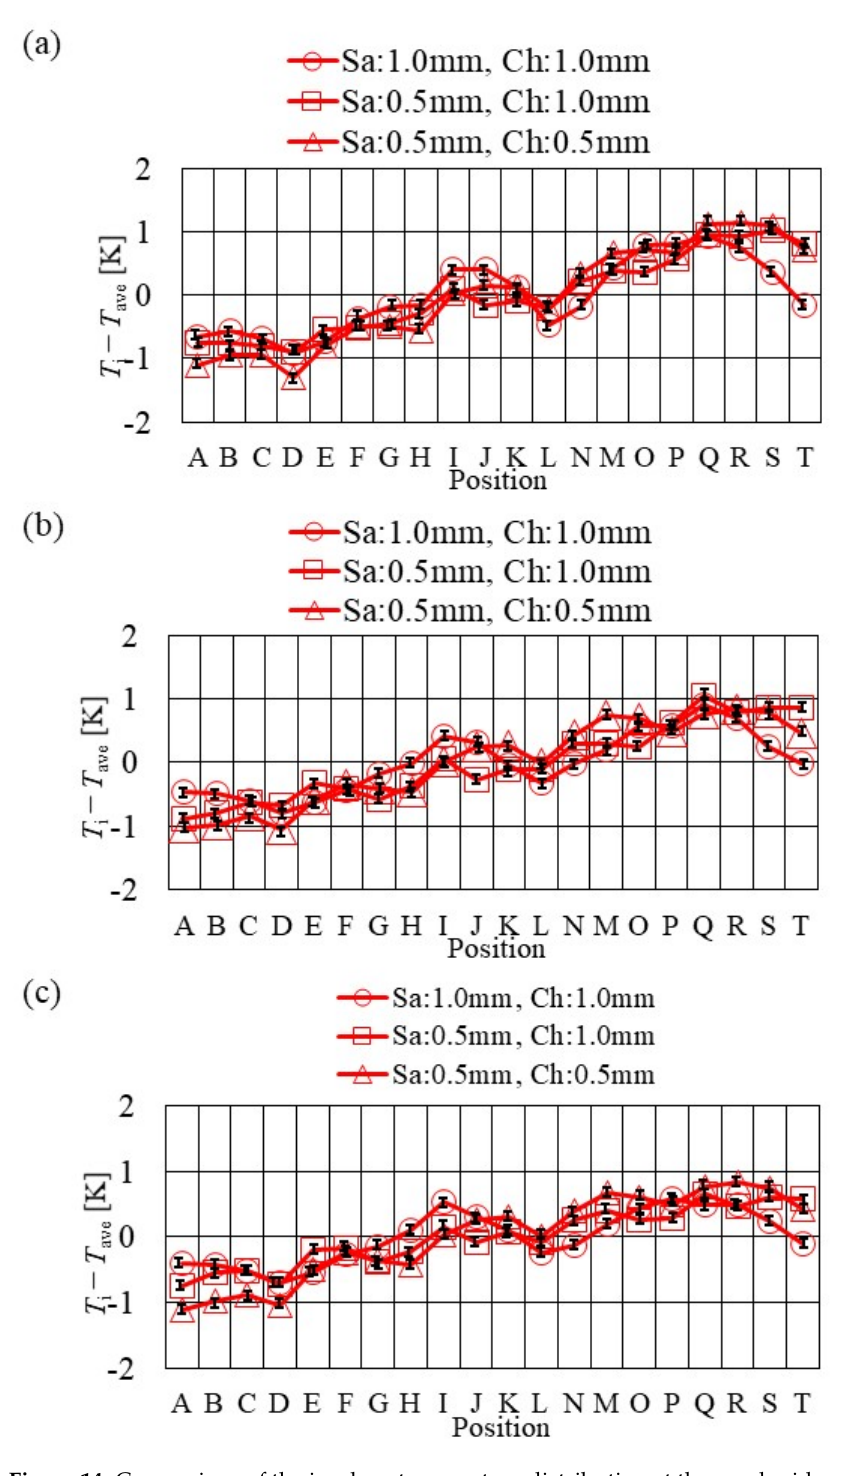
Figure 14. Comparison of the in-plane temperature distribution at the anode side among different separator thicknesses with A40%RH&C40%RH: ( a ) T init = 353 K; ( b ) T init = 363 K; ( c ) T init = 373 K.